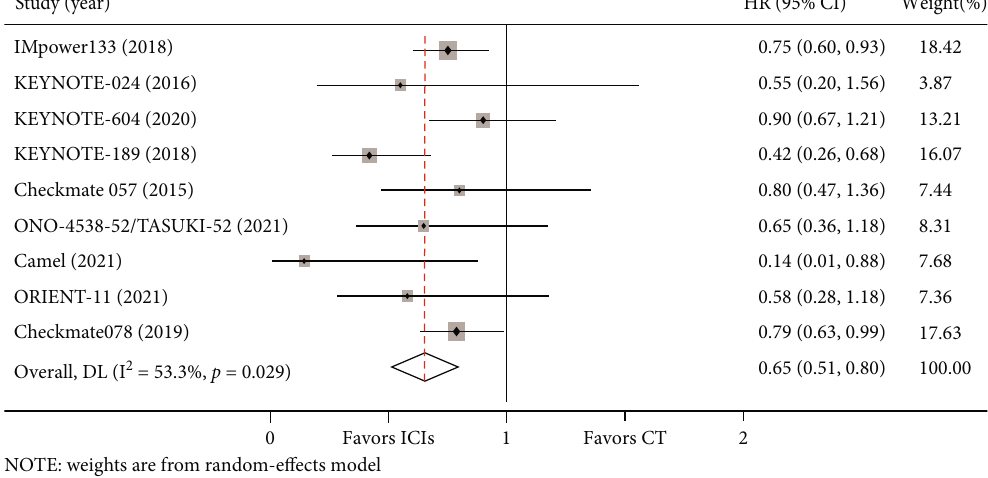
Figure 5: Subgroup analyses of OS by histology between immune checkpoint inhibitors (ICIs) group and chemotherapy (CT) group for lung cancer with BM.